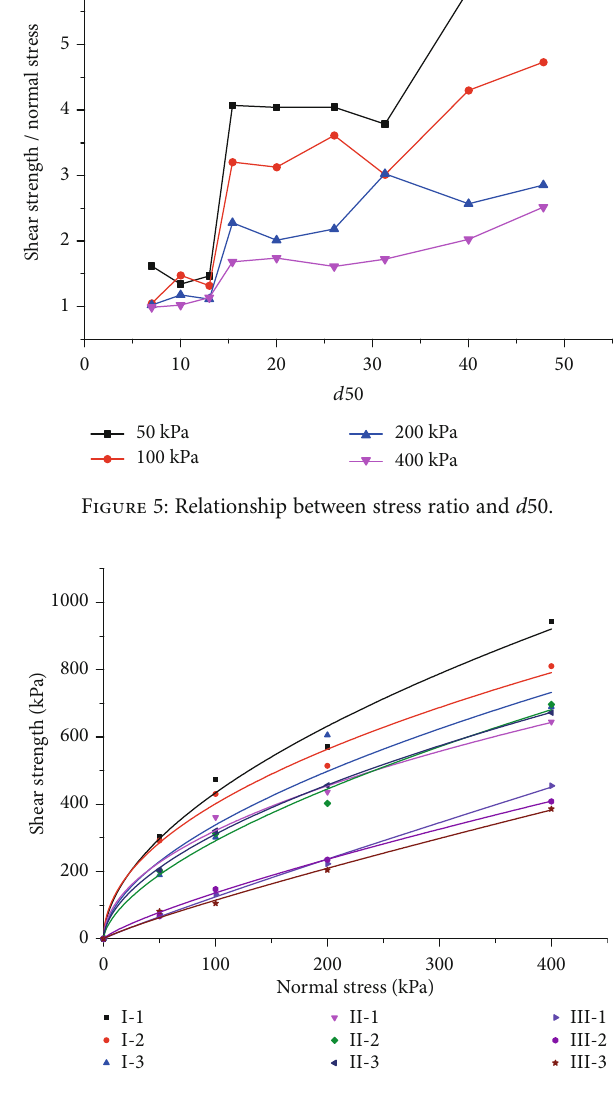
Figure 6: Shear strength versus normal load fi tting diagram on the basis of power function.